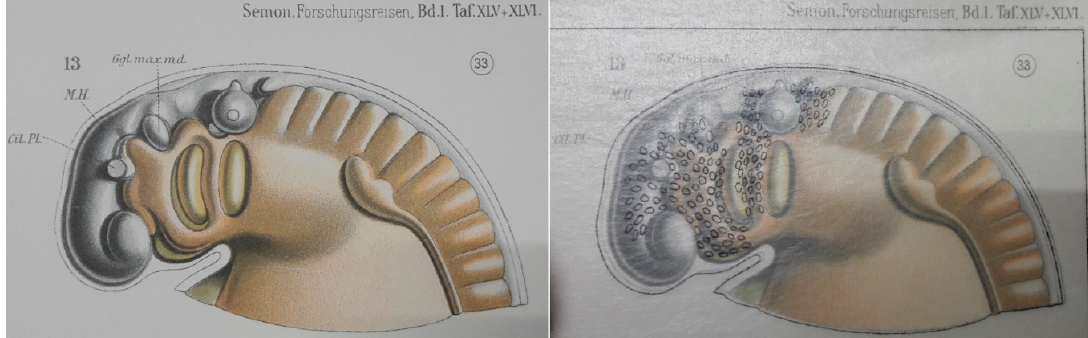
Figure 1. Neural crest cells migrating down the pharyngeal arches of a stage 33 embryonic Australian lungfish. Transparent overlay paper was used in this description from 1908 to show the migration (black ovals in right-hand image represent the positions of neural crest cells). Photographed from [8].